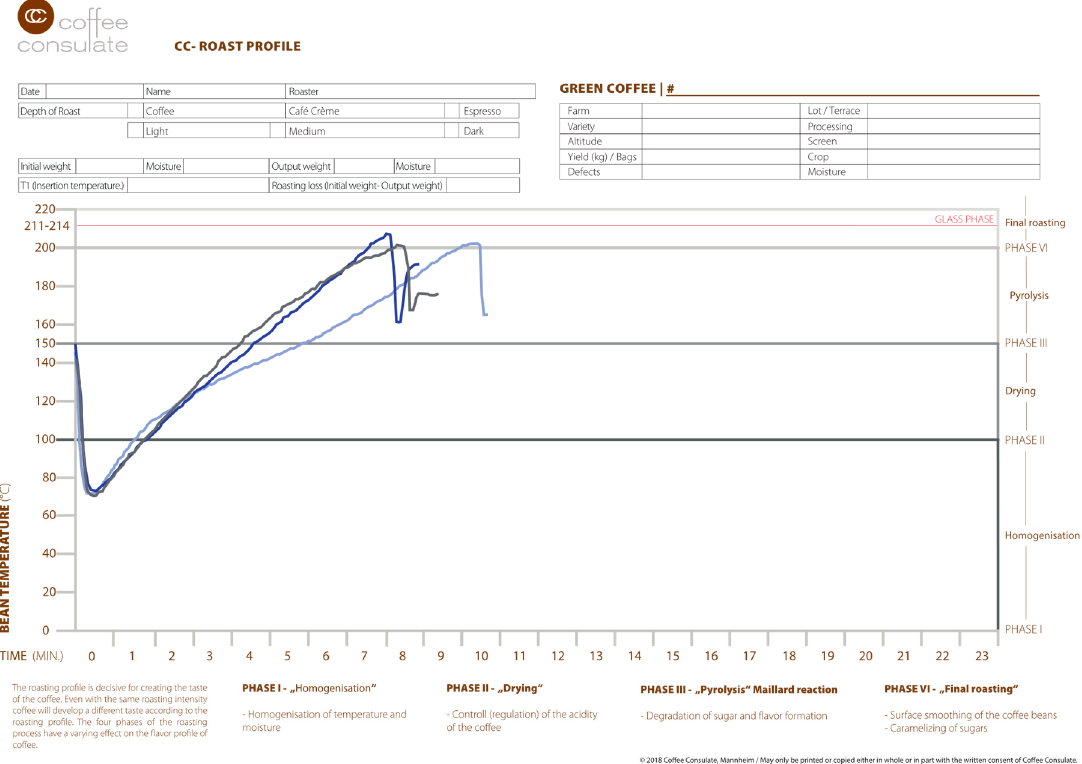
Figure 1. Exemplary roasting profiles of cold brew (gray line) compared with filter coffee (dark blue line) and espresso (light blue line) (FZ-94 sample roaster, Coffee-Tech Engineering, Moshav Mazliach, Israel).